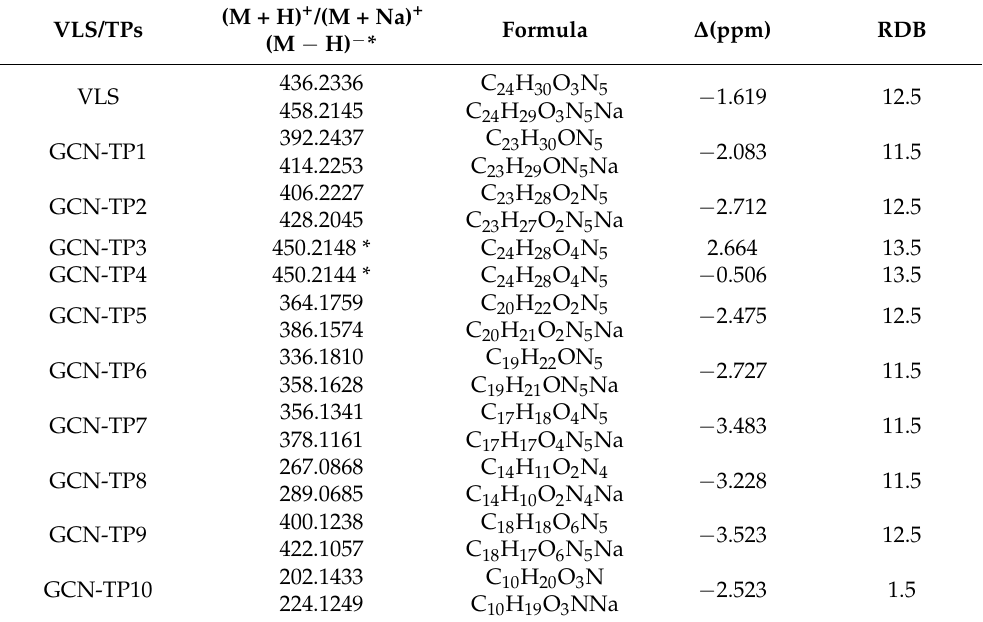
Table 1. UPLC-ESI-HR-MS data (pseudo-molecular ions (M + H) + or (M − H) − * /(M + Na) + ; chemical formula; mass error ∆ (ppm); and ring-double \ bond equivalents, RDB) for VLS and transformation products by g-C 3 N 4 photocatalytic oxidation. (M + H) + /(M + Na) + VLS/TPs Formula ∆ (M − H) − *